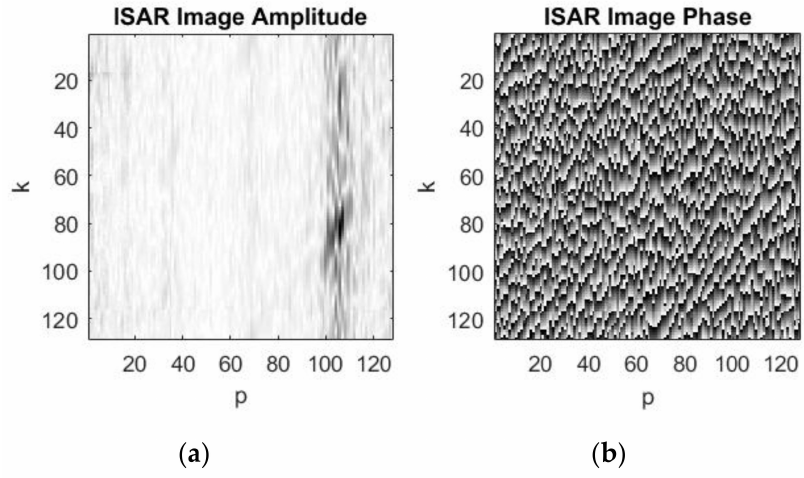
Figure 9. Resulting complex image after 3rd additive summation of complex images: ( a ) ISAR image amplitude; ( b ) ISAR image